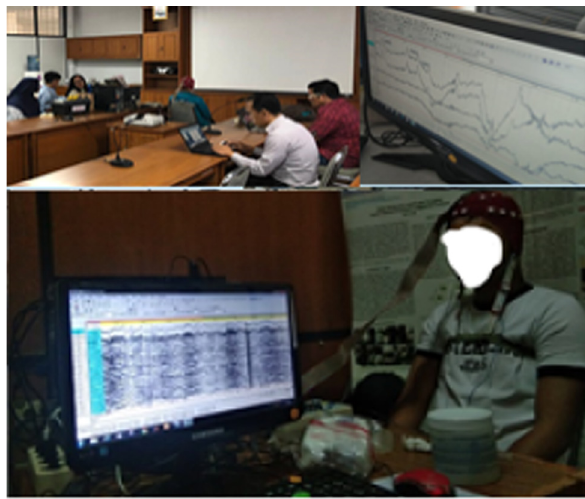
Figure 2: Experiment setup of the soy peptide e ff ect on brain wave activity in open eye condition.